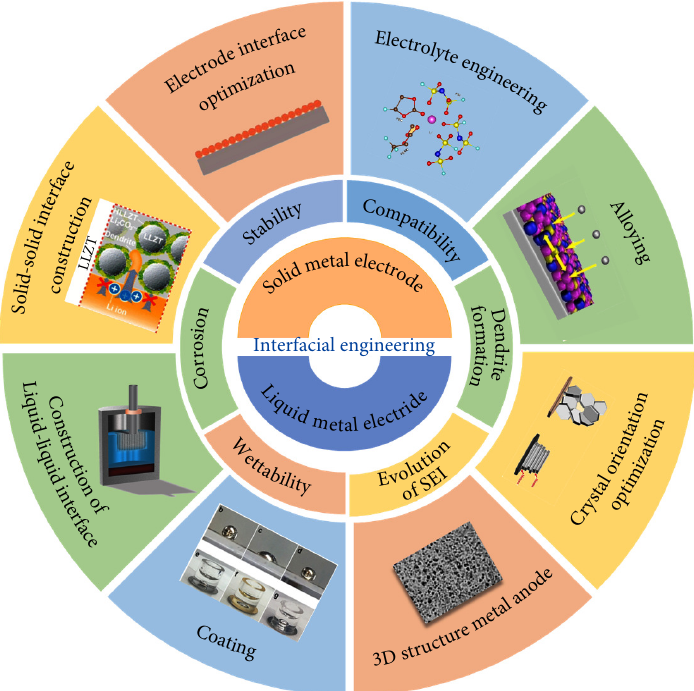
Fig. 1 An overview of the development of metal electrode batteries, including the interface issues of the solid metal electrodes and liquid metal electrodes (the ring layer in the middle), and responding interface engineering strategies (the outer ring layer).